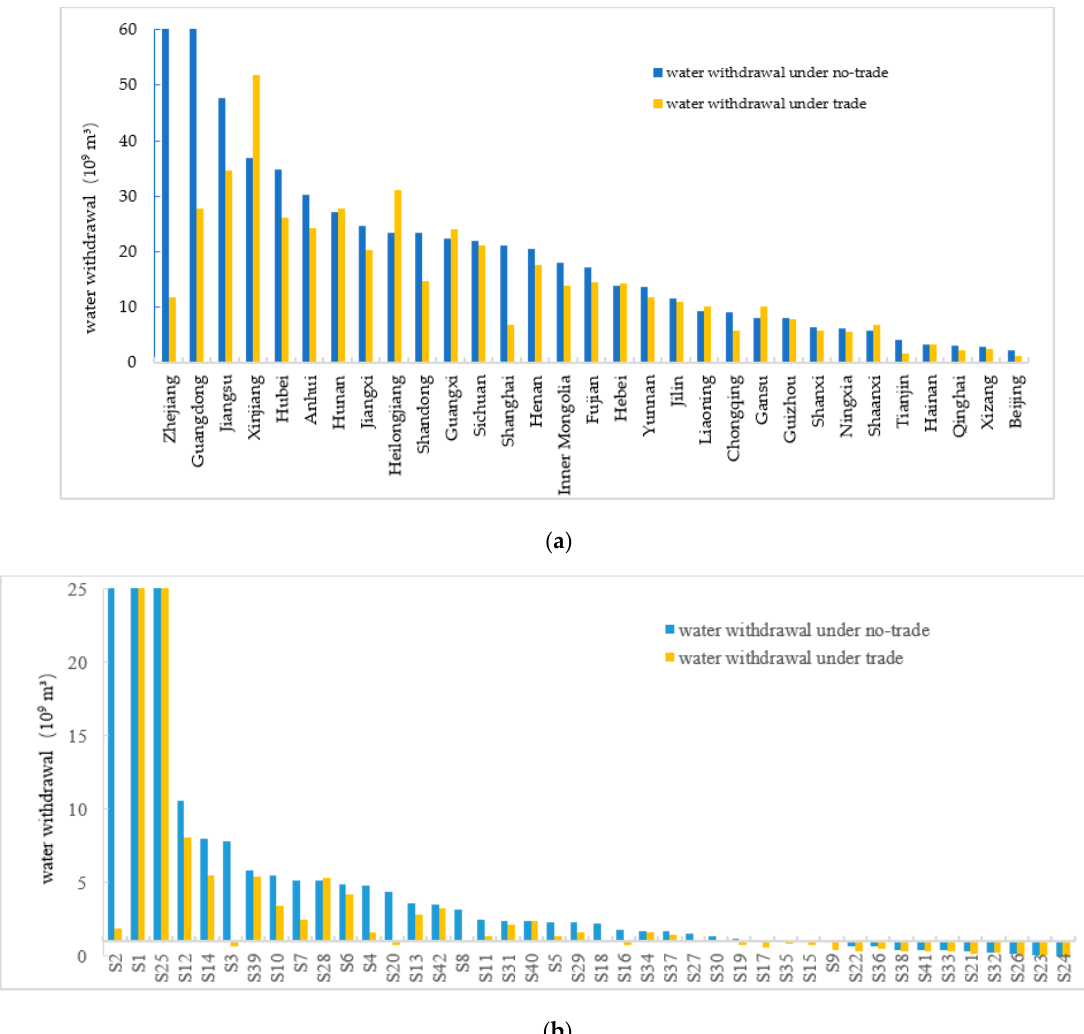
Figure 3. Water withdrawal under trade and under no-trade ( a ) by region and ( b ) by sector. Note: water withdrawal without trade in Zhejiang and Guangdong is 234.92 × 10 9 m 3 and 202.5 × 10 9 m 3 , respectively; water withdrawal without trade in S1, S2 and S25 is 354.74 × 10 9 m 3 , 380.53 × 10 9 m 3 , 75.59 × 10 9 m 3 , respectively; water withdrawal with trade in S1 and S25 is 343.76 × 10 9 m 3 and 56.18 × 10 9 m 3 , respectively.